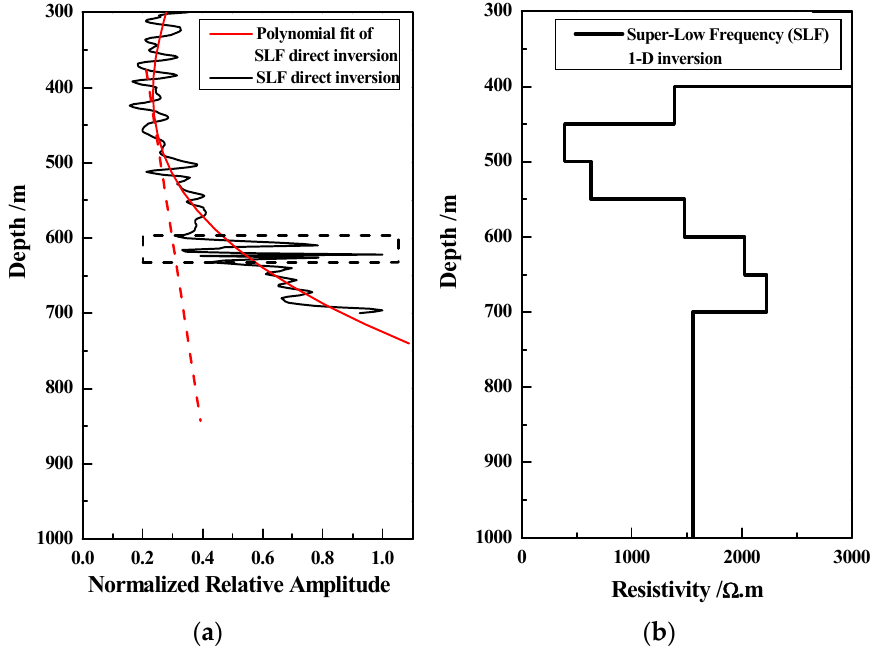
Figure 16. ( a ) Direct depth transformation and ( b ) the one-dimensional inversion results of Well 1-5. Note: The solid red line in the figure represents the polynomial fitting curve of the internal source field characteristics, the red dashed line represents the approximate SLF response trend line, and the dashed box circles the distribution range of abnormal signals.